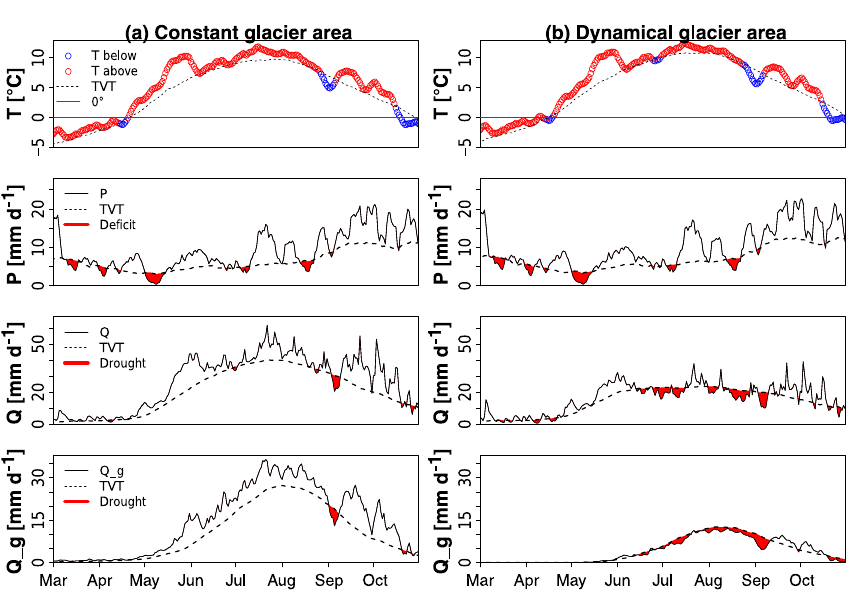
Figure 9. Example of streamflow droughts and causing factors ( T , P and Q g ) for the different glacier area conceptualisations. Multi-model mean temperature, precipitation and discharge time series are presented for the Nigardsbreen catchment for March–October 2092, based on climate scenario RCP8.5. For the time series of P and T , a 7-day moving average was used. Droughts are analysed with the transient threshold. Note that T and P are slightly different in the panels (a) and (b) due to different lapse rates obtained during the